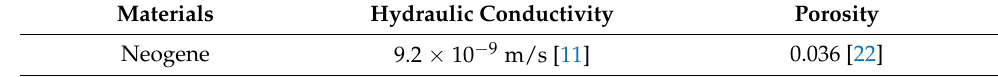
Table 3. Hydraulic conductivity and porosity.